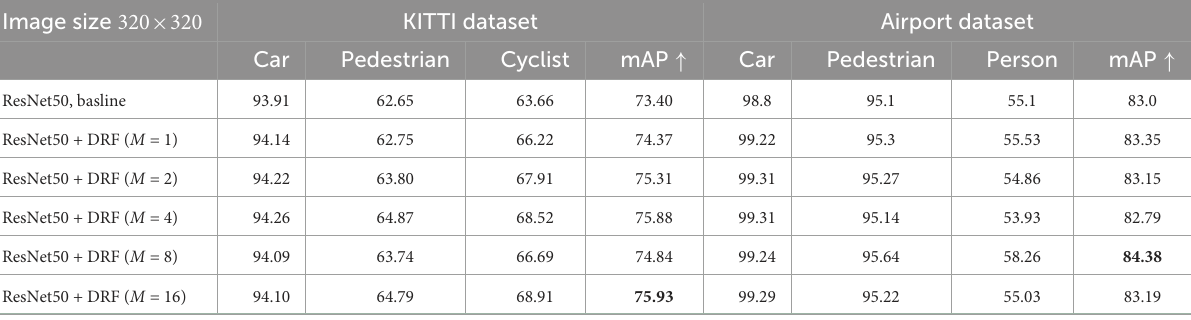
TABLE 4 Detection results on KITTI dataset and Airport dataset by replacing the penultimate residual block of the last stage of Resnet50 with the proposed head-num of M-DRF block.